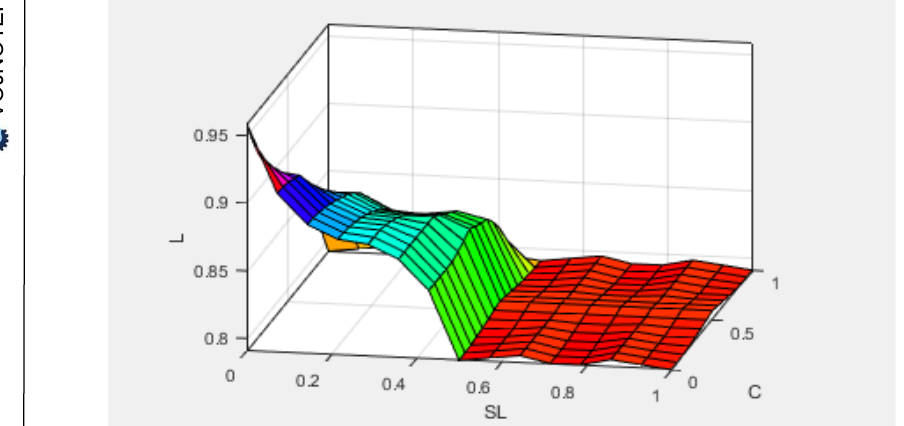
Figure 7 – 3D Plot of the fuzzy output of smart street lighting Рис. 7 –3Д-график нечеткого вывода умного уличного освещения Слика 7 – 3Д приказ фазног излаза паметног уличног